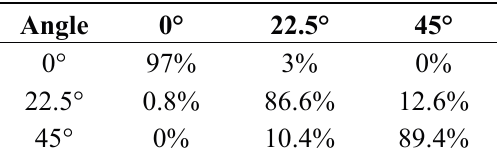
Table 1. Confusion matrix of the detected angles using the GMM model.